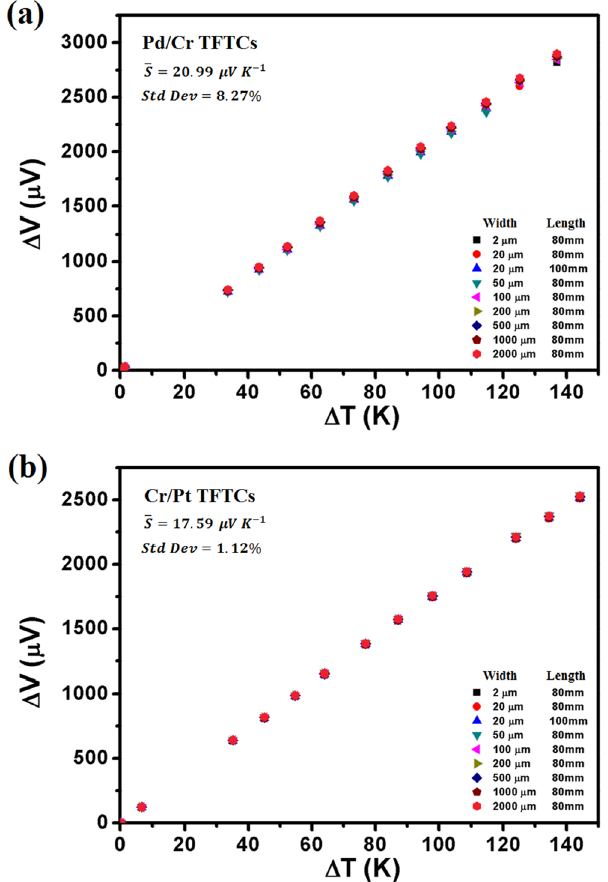
Figure 3. Calibration results of the Pd/Cr and Cr/Pt TFTCs. The calculated thermopower is the average value of 9 different TFTCs. ( a ) Calibration results of 9 different Pd/Cr TFTCs. These TFTCs have varied stripe width of 2 μ m, 20 μ m, 50 μ m, 100 μ m, 200 μ m, 500 μ m, 1000 μ m, and 2000 μ m, and different stripe length of 80 mm and 100 mm. The calculated thermopower of Pd/Cr TFTCs is 20.99 ± 0.1 μ V/K, with a standard deviation of 8.27%. ( b ) Calibration results of 9 different Cr/Pt TFTCs. These TFTCs have the same size with the Pd/Cr TFTCs. The calculated thermopower of Pd/Cr TFTCs is 17.59 ± 0.3 μ V/K, with a standard deviation of